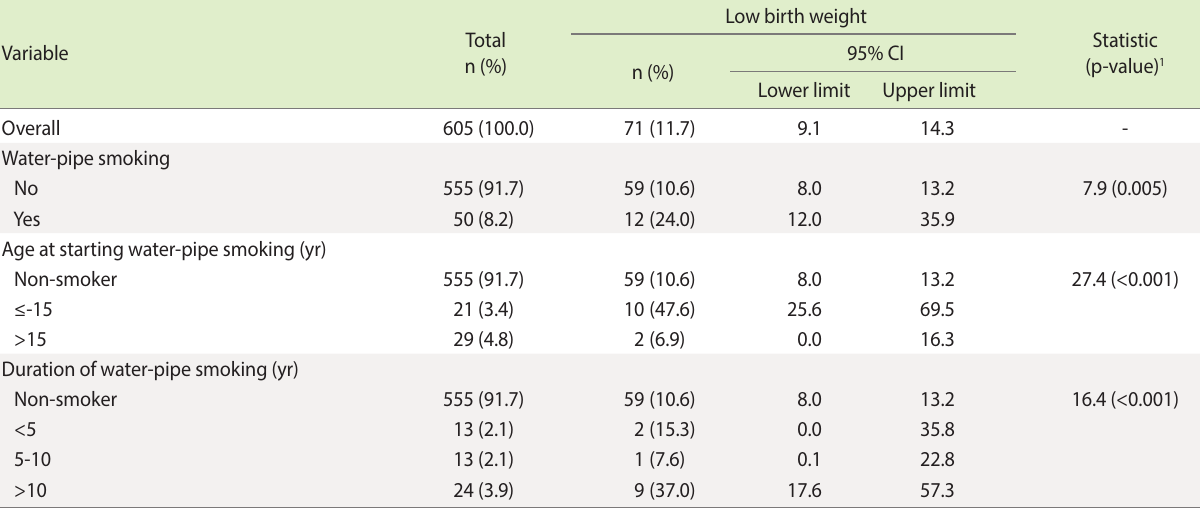
Table 2. Proportion of low birth weight infants according to water-pipe smoking in pregnant women in Bandar Abbas, Iran, 2016-2017